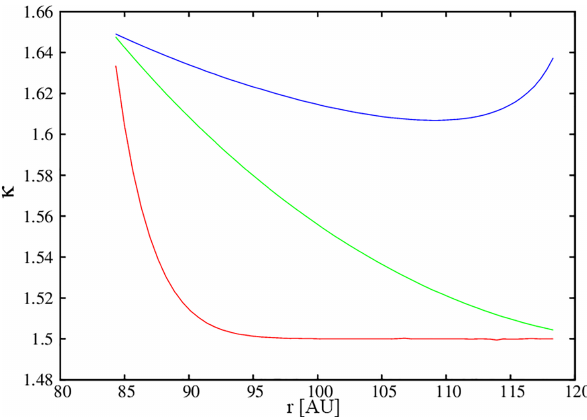
Figure 3. κ evolution for three different momentum diffusion co- efficients: D 0 = 10 − 10 , 10 − 9 , 10 − 8 (red, green, and blue curve, re- spectively) along the Voyager 2 trajectory. See Fahr et al. (2016) for details.